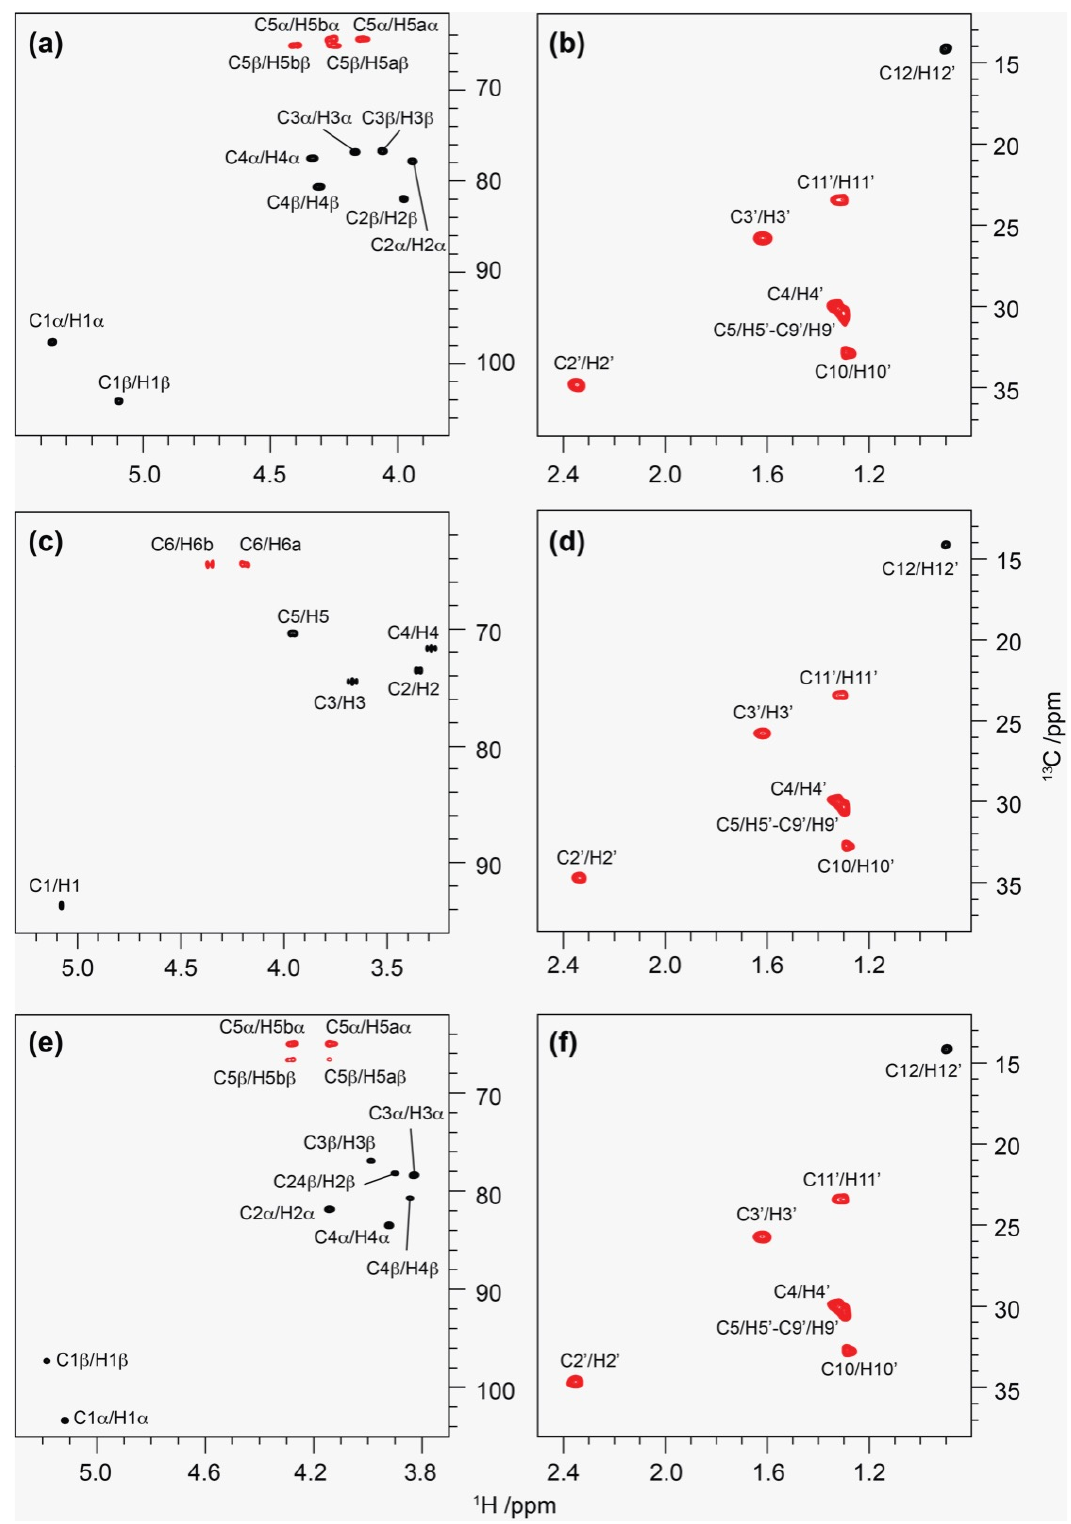
Figure 2. Selected regions of the of the multiplicity-edited 1 H, 13 C-HSQC spectra (500 MHz, 298 K, MeOD-d 4 ) of ( a , b ) 5- O -lauroyl- D -xylofuranose ( 4 ), ( c,d ) 6- O -lauroyl- D -glucopyranose ( 5 ) and ( e , f ) 5- O -lauroyl- D -arabinofuranose ( 6 ) showing one-bond proton-carbon correlations from the sugar (left panels ( a ), ( c ) and ( e ), respectively) and lauroyl moieties (right panels ( b ), ( d ) and ( f ), respectively).